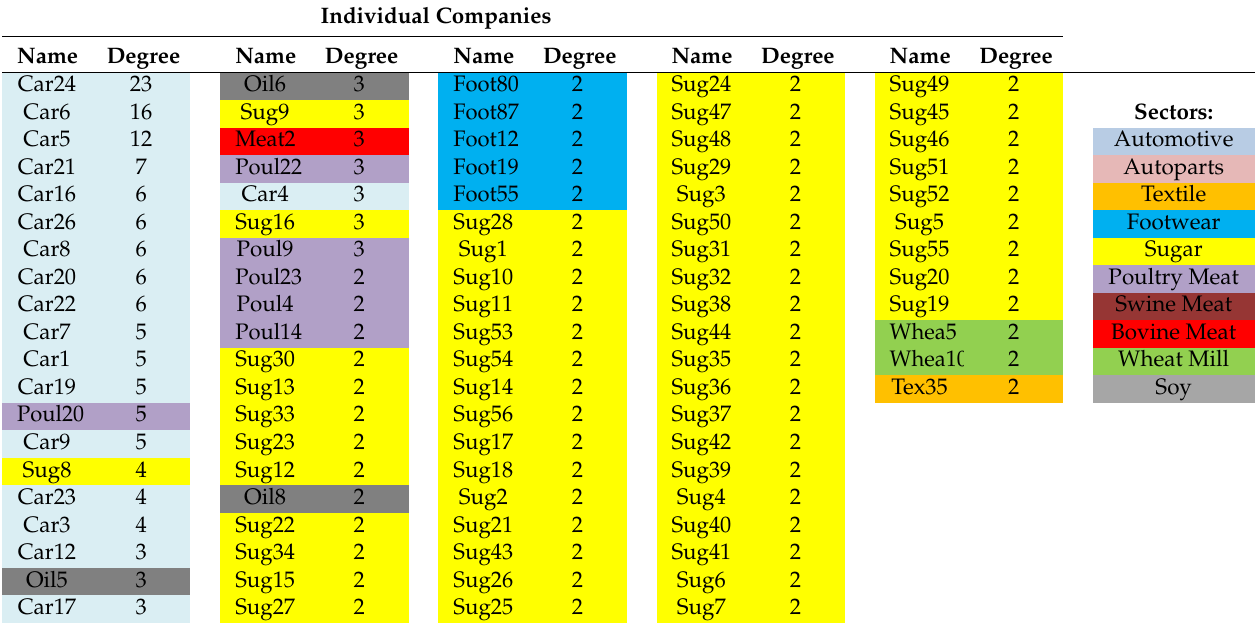
Note: The color represents different sectors. See color key